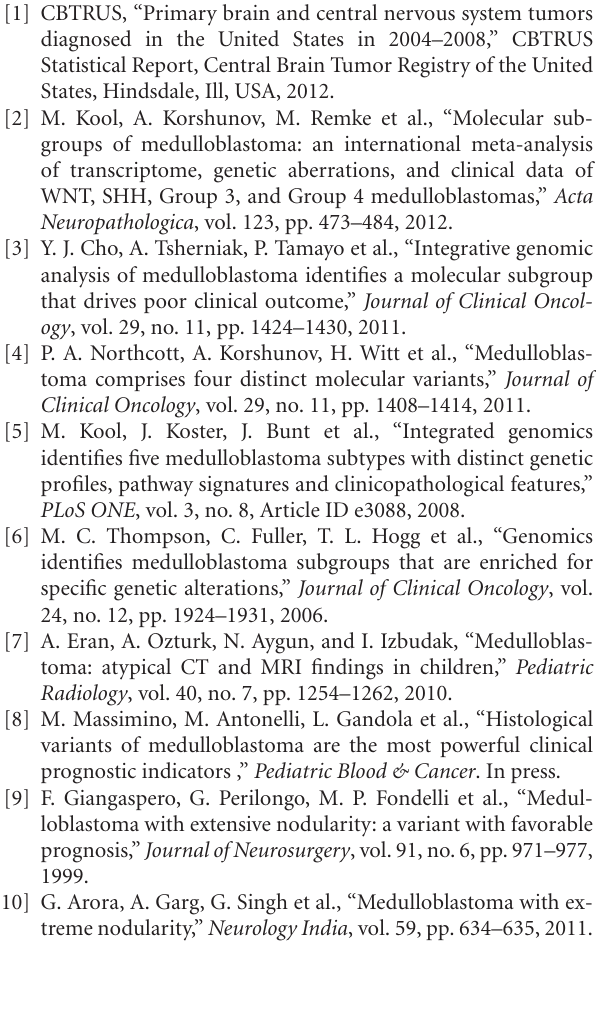
ADC: Apparent di ff usion coe ffi